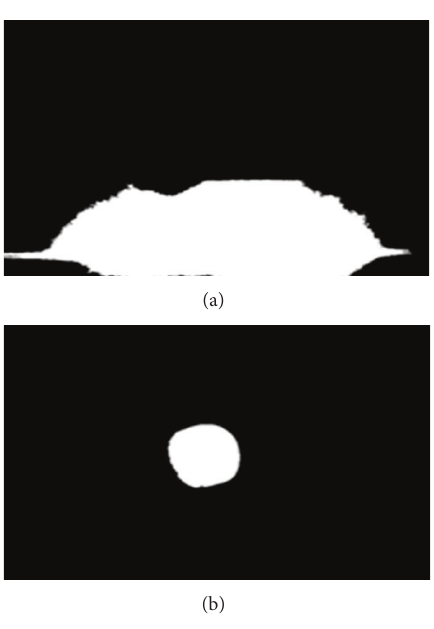
Figure 3: Direct illuminated apple image with (a) halogen lamps, (b) fluorescent lamps.